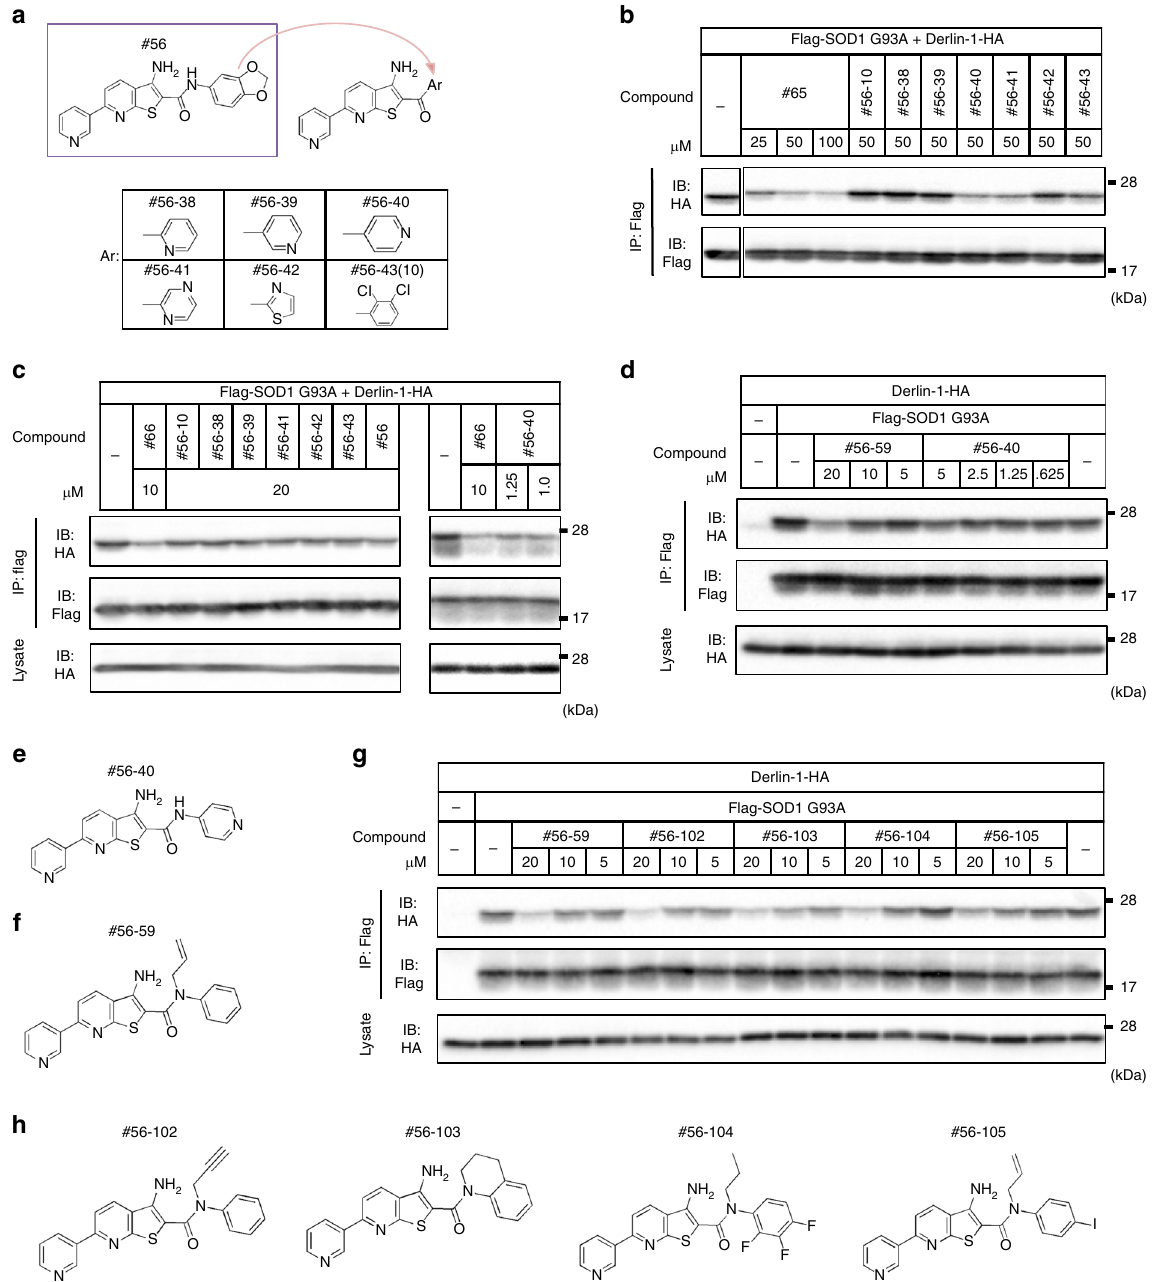
Fig. 3 Identi fi cation of cell-permeable compounds. a Chemical structure of newly synthesized #56 analogs. #56-43 is the resynthesized #56-10. b Inhibition of SOD1 G93A -Derlin-1 interaction by new #56 analogs in in vitro IP assay. The SOD1 G93A -Derlin-1 complex puri fi ed from lysates transfected with Flag-SOD1 G93A and Derlin-1-HA was incubated with the indicated compounds for 16 h and analyzed by IP-IB with the indicated antibodies. c , d Inhibition of SOD1 G93A -Derlin-1 interaction by #56 analogs in a cell-based IP assay. HEK293A cells transfected with indicated plasmids were treated with the indicated compounds for 24 h, and lysates were analyzed by IP-IB with the indicated antibodies. c Inhibition of SOD1 G93A -Derlin-1 interaction by the same compounds as in the in vitro assay b in a cell-based assay. Compound #66 is used as a positive control of a cell-permeable inhibitor, although the resynthesized #66 does not show any activities. d Two cell-permeable SOD1 G93A -Derlin-1 interaction inhibitors in a cell-based IP assay. e , f Chemical structure of #56-40 and #56-59. g Inhibitory activities of other compounds containing tertiary amide groups, #56-102-105, in the cell-based IP assay as in c , d . h Chemical structure of #56-102, 103, 104, and